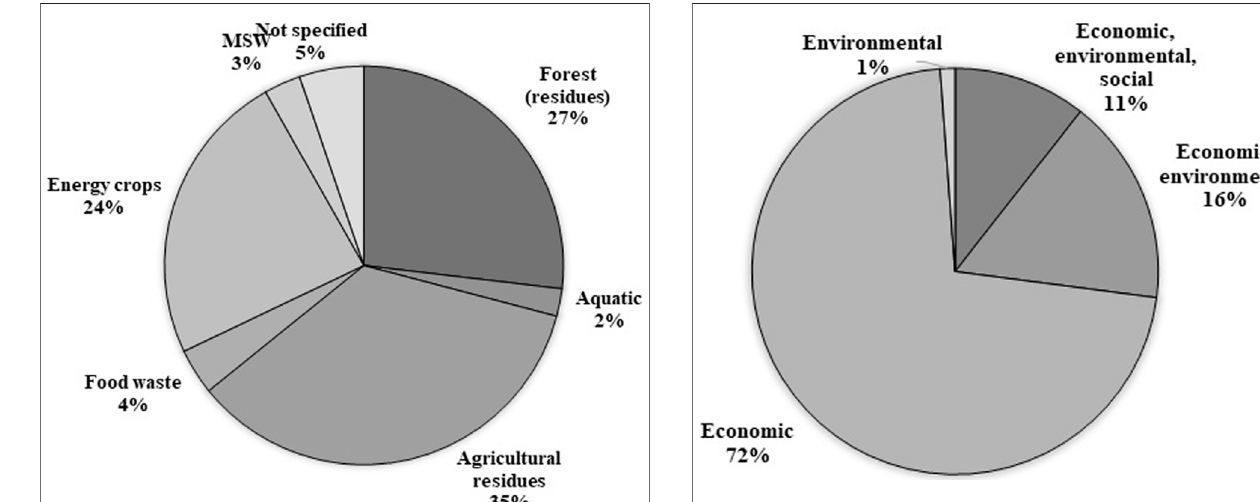
FIGURE 4 | Biomass sources studied in the models in the database.